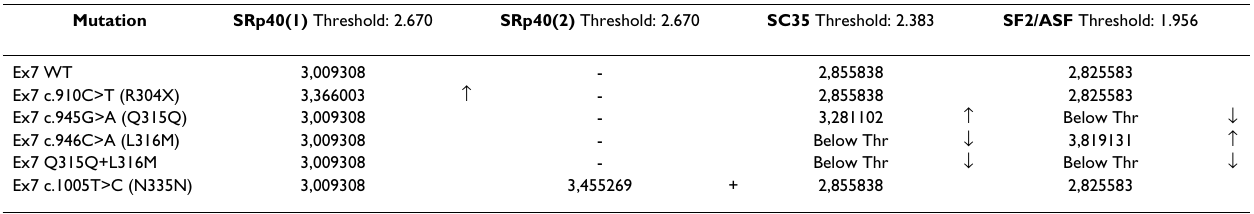
Table 2: ESE Finder results for NF1 exon 7 mutations. Mutation SRp40(1) Threshold: 2.670 SRp40(2) Threshold: 2.670 SC35 Threshold: